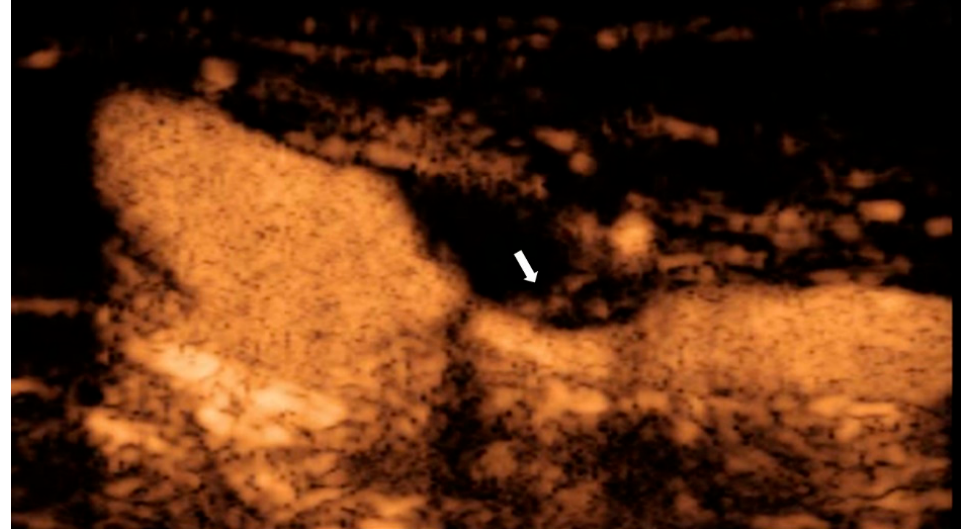
Figure 5. CEUS of a 71-year-old man with asymptomatic severe carotid stenosis. Contrast inflow into the plaque is observed (arrow), suggesting the presence of neovascularization.